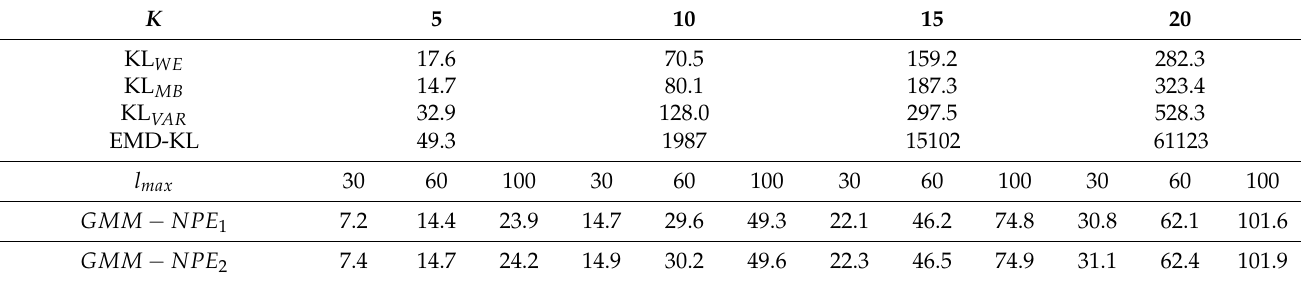
Table 9. Average processing CPU times for the proposed GMM-NPEs, in comparison to the baseline measures, as a function of number of GMM components K used, as well as dimension of the reduced space l max (unit: [ms]). K